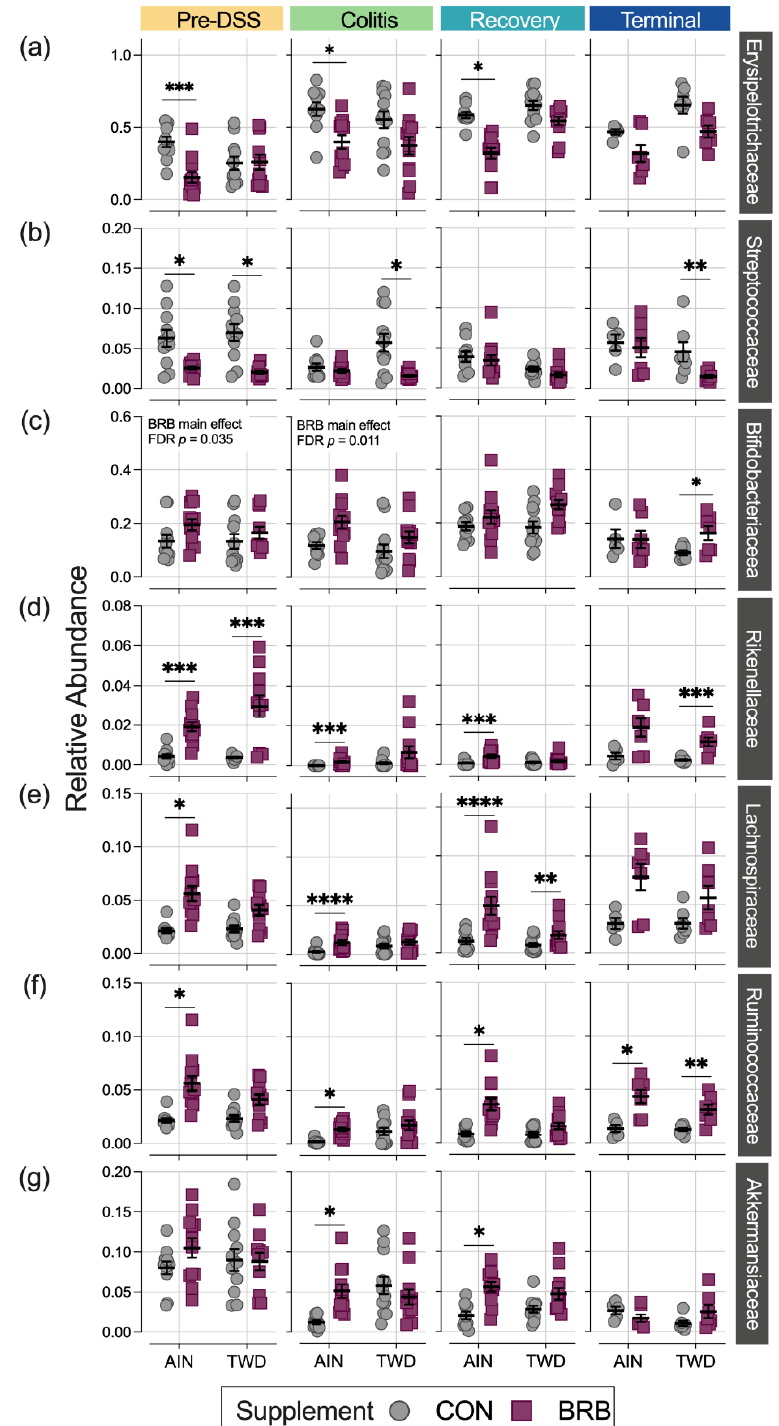
Figure 9. Relative abundance of select bacteria families of interest for each experimental time point (experiment B). ( a ) Erysipelotrichaceae, ( b ) Streptococcaceae, ( c ) Bifidobacteriaceae, ( d ) Lachnospiraceae, ( e ) Rikenellaceae, ( f ) Ruminococcaceae and ( g ) Akkermansiaceae. Data are shown as individual values that represent each cage (as the biological unit) with mean ± SE. For simplified visualization, this plot shows only the statistical results as FDR-corrected p -values for comparisons between CON and BRB-supplemented diets as indicated: *, p < 0.05; **, p < 0.01; ***, p < 0.001; and ****, p < 0.0001, as outlined in Materials and Methods. Complete results of all metagenomeSeq statistical analyses, including pairwise comparisons by basal diet and across time points, are provided in File S4.